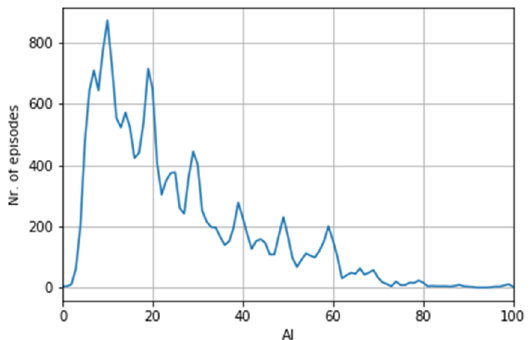
Figure 8. Number of episodes x Kg of Al that has been added.